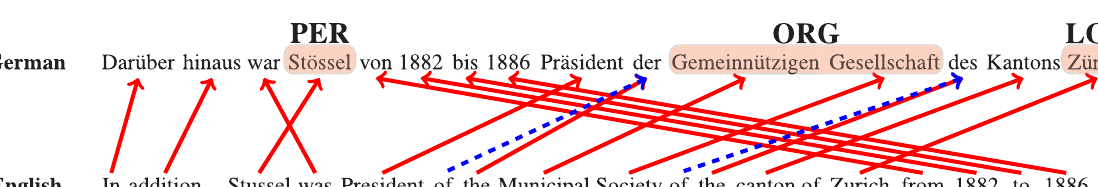
Fig 4. An example of word alignment visualization between a German sentence and its English translation, where the solid arrows are gold-standard being all correctly predicted by XLM, and the dashed arrows are incorrectly aligned by mBERT, and the others are the same for the two types of word representations.